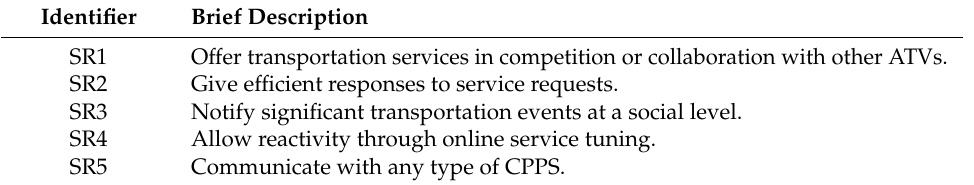
Table 1. Specific requirements (SR) of an ATV in a flexible manufacturing